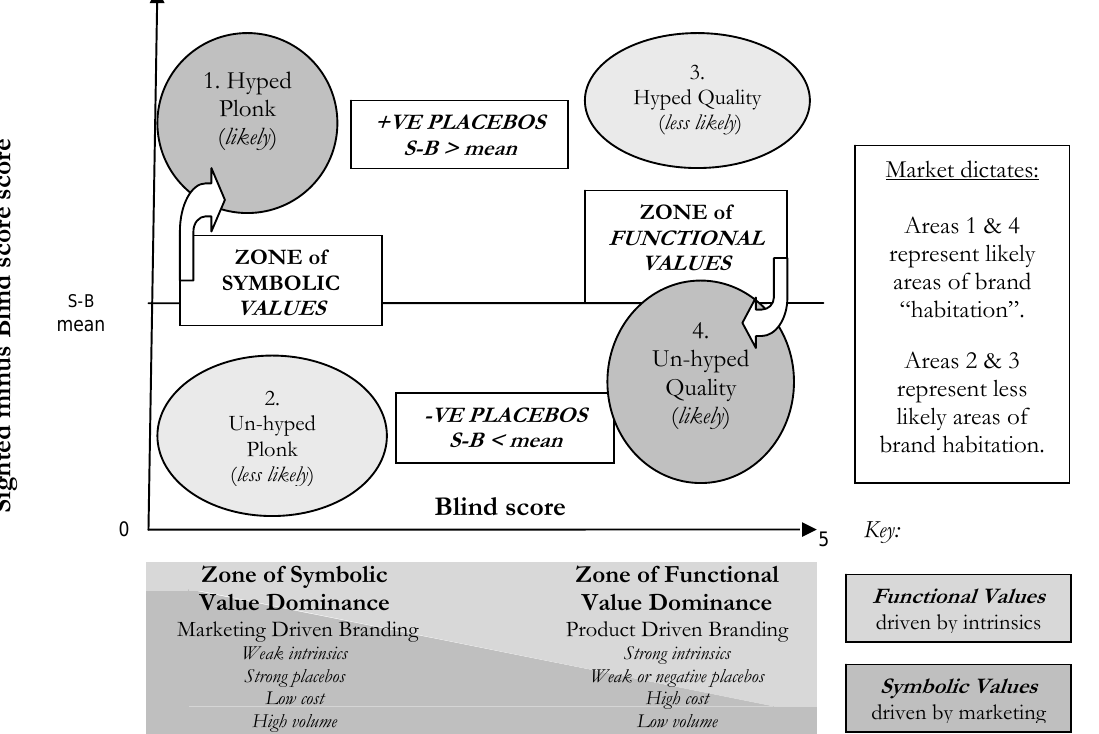
Figure 1 : Proposed area of potential placebo-brand habitation : a region of brands spanning a continuum of intrinsic hedonic quality (as proxied by the blind wine score). Notionally placebo distribution should align with market realities: around the mean of blind scores; thinning out at the tails. The area of low blind scores (to the left) can attract placebos either as (1) “Hyped Plonk” (with positive placebos) or (2) as “Un-hyped Plonk” (with negative placebos). Areas of high blind scores (to the right) can attract placebos either as (3) “Hyped Quality” (with positive placebos) or (4) “Un-hyped Quality” (with negative placebos). Market realities suggest lesser-shaded areas 2 and 3 are unfeasible. Thus area 1 is the likely domain of marketing driven branding: the Zone of Symbolic Values (see Bhat and Reddy (1998) and Mowle and Merrilees (2005)). Conversely, area 4 with high blind scores (to the right), should attract small or negative placebos. This is the domain of product driven branding: the Zone of Functional Values